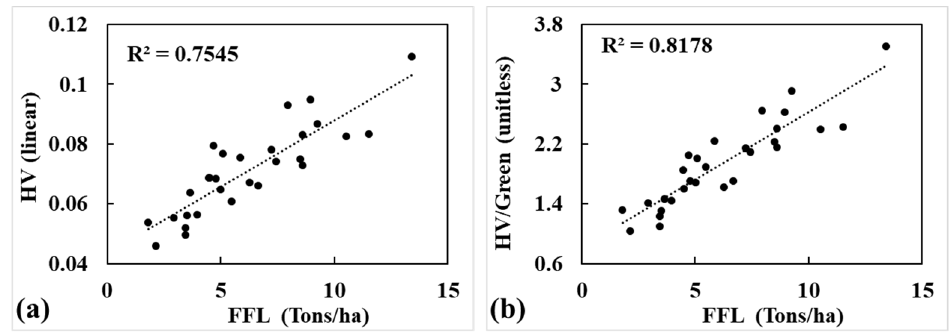
Figure 6. The correlation relationship between HV and FFL ( a ), and HV/Green and FFL ( b ).